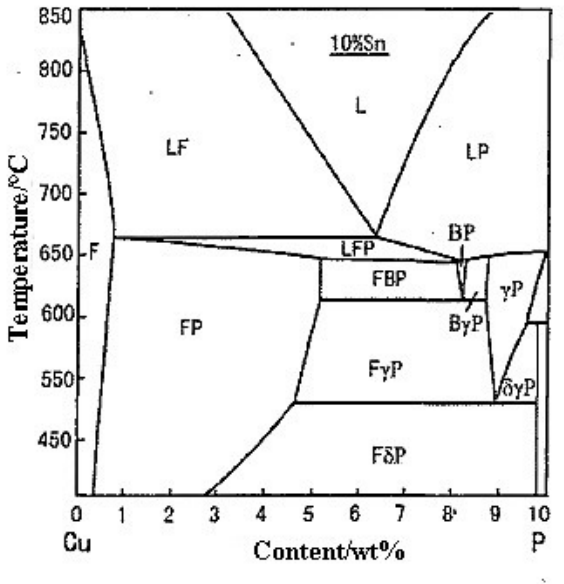
Figure 3: Cu-P-Sn ternary phase diagram (10% Sn). “F” indicates Cu 13.7 Sn (face-centered cubic); “B” indicates Cu 5.6 Sn (body- centered cubic); “P” indicates Cu 3 P (cubic); and “ δ ” indicates Cu 41 Sn 11 (cubic)